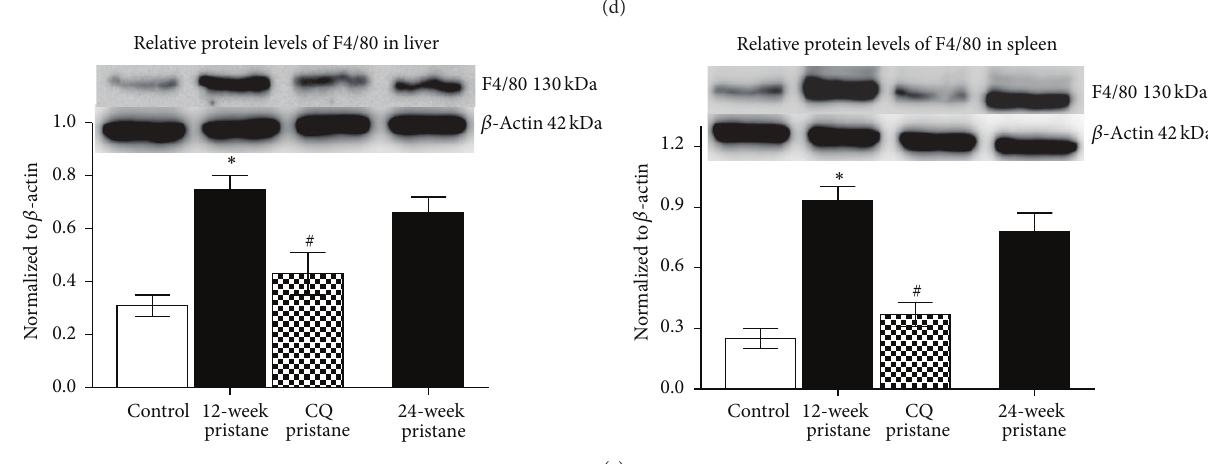
Figure 1: Hemophagocytosis, extramedullary hematopoiesis, and macrophage infiltration in liver and spleen. Hemophagocytosis (arrow), extramedullary hematopoiesis (arrow head) in liver and spleen were illustrated by HE staining ((a), (b)). The distribution and expression of F4/80 in liver and spleen were depicted with immunohistochemistry ((c), (d)) and western blotting (e), respectively. × 200; inset, × 400. CQ: chloroquine. Results were expressed as mean ± SE for eight animals. ∗ 𝑃 < 0.05 versus corresponding control mice, # 𝑃 < 0.05 versus mice exposed to pristane for 12